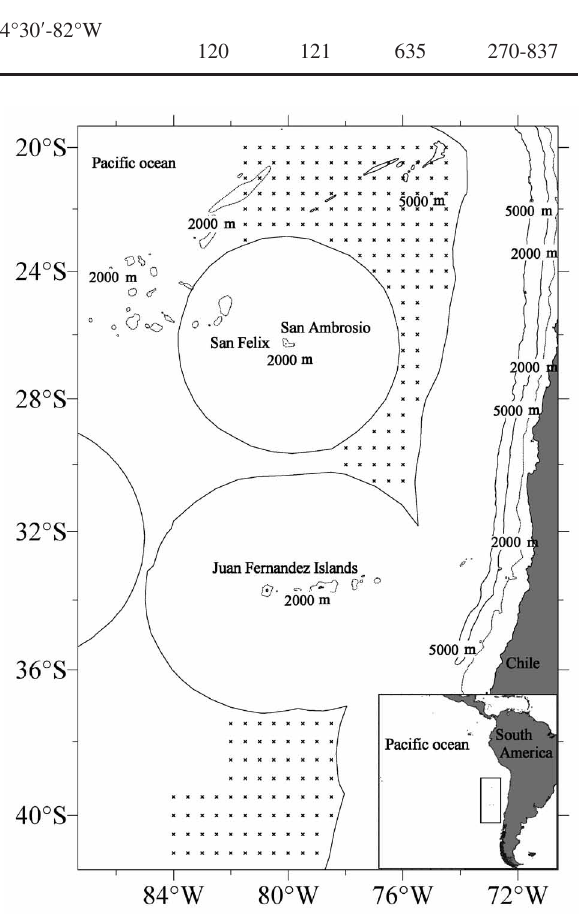
Fig . 1. – Three survey areas covered by the Chinese squid jigger vessels off Chile between April 2006 and May 2008. The constant line and asterisks represent the Exclusive Economic Zone and planned survey stations, respectively.